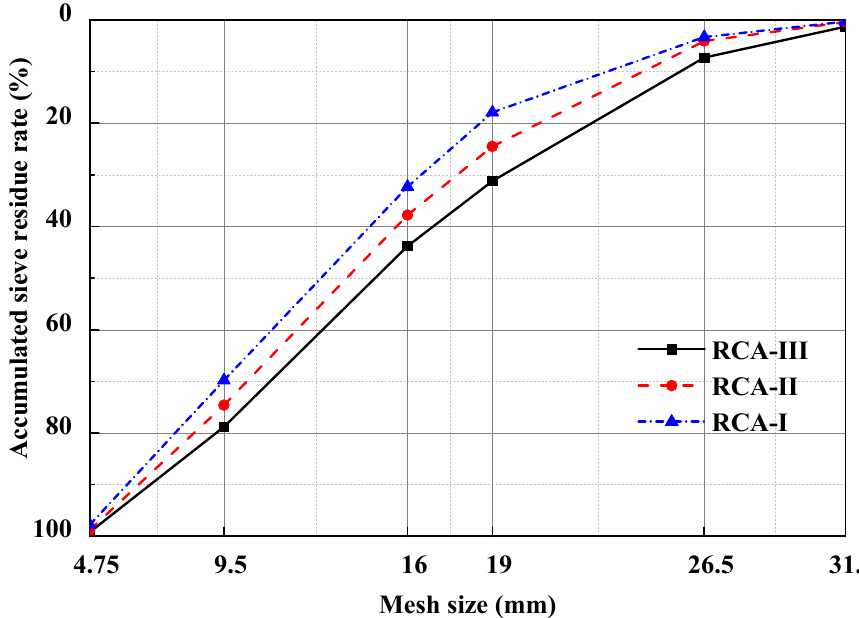
Figure 2. Gradation curve of the different recycled coarse aggregates.